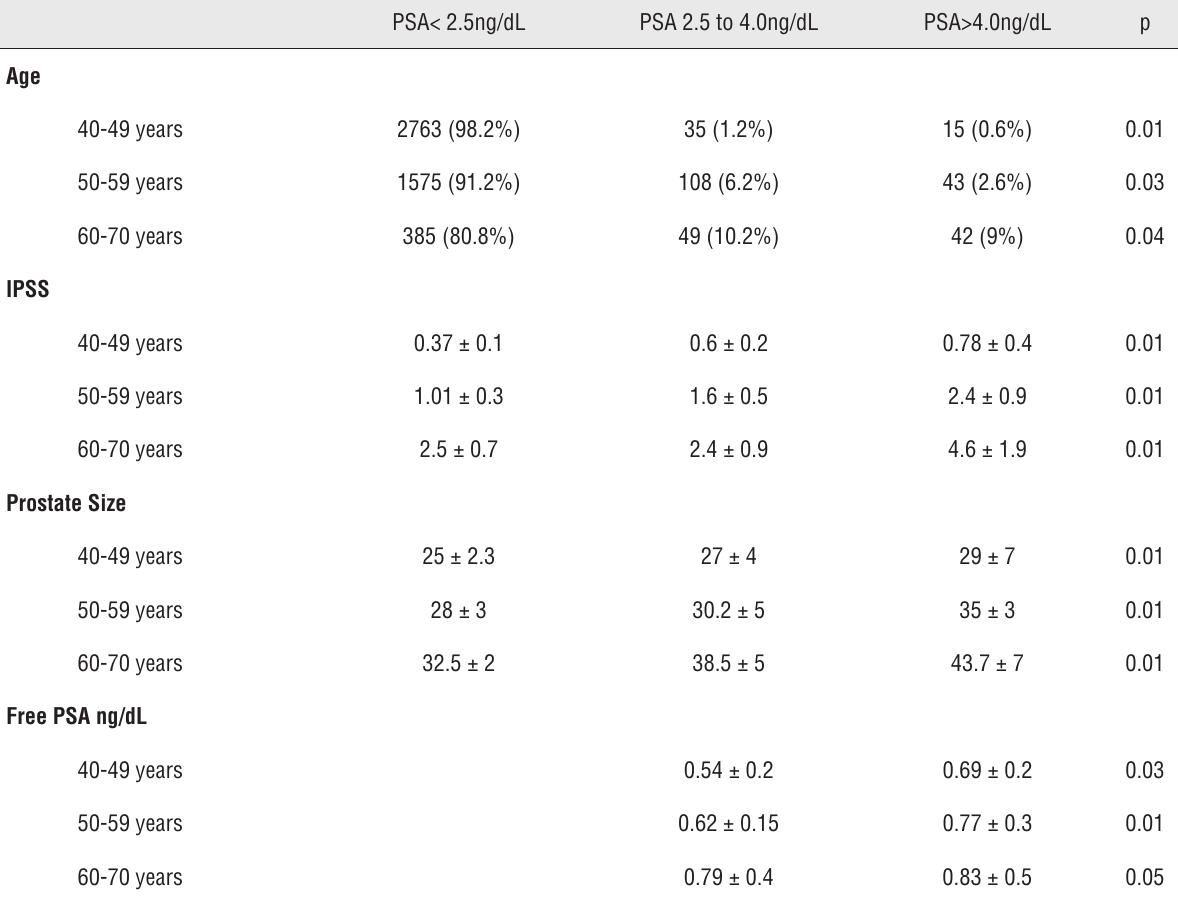
Table 3 - Prevalence of PSA less than 2.5, PSA between 2.5 and 4.0, and PSA greater than 4.0ng/dL in the different aging